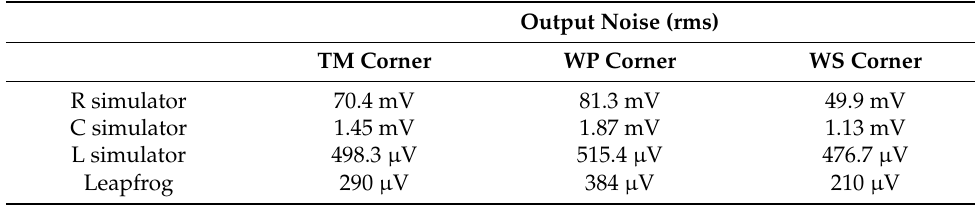
Table 7. Corner analysis of the output noise.